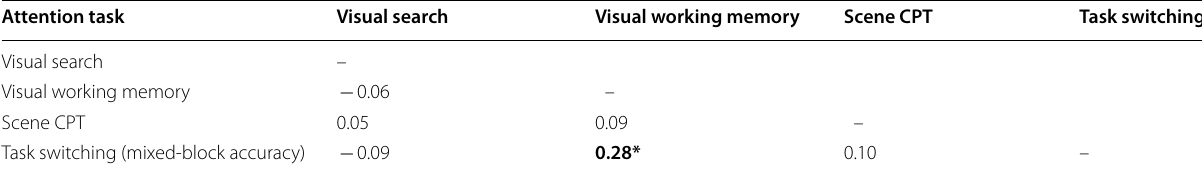
Bold indicates uncorrected p <